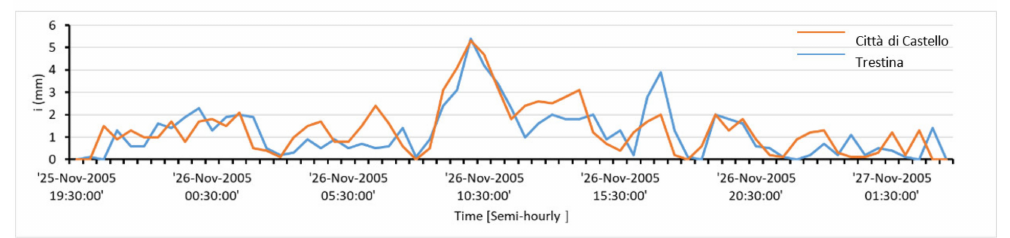
Figure 2. Semihourly rainfall intensity recorded by rain gauges of Trestina (blue line) and Citt à di Castello (orange line).